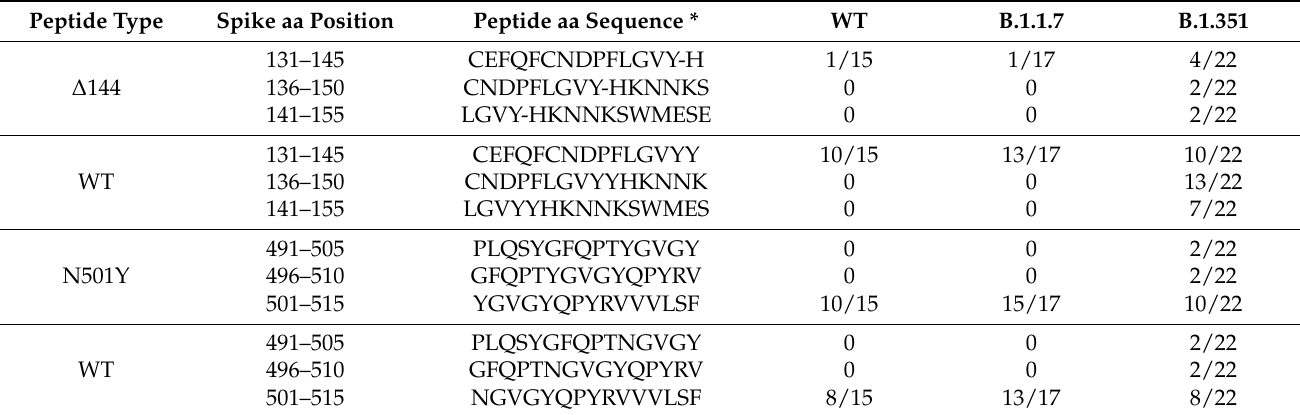
Table 2. Fraction of “positive” linear WT and the mutated peptides detected by sera obtained from convalescent mice obtained after infection with the three SARS-CoV-2